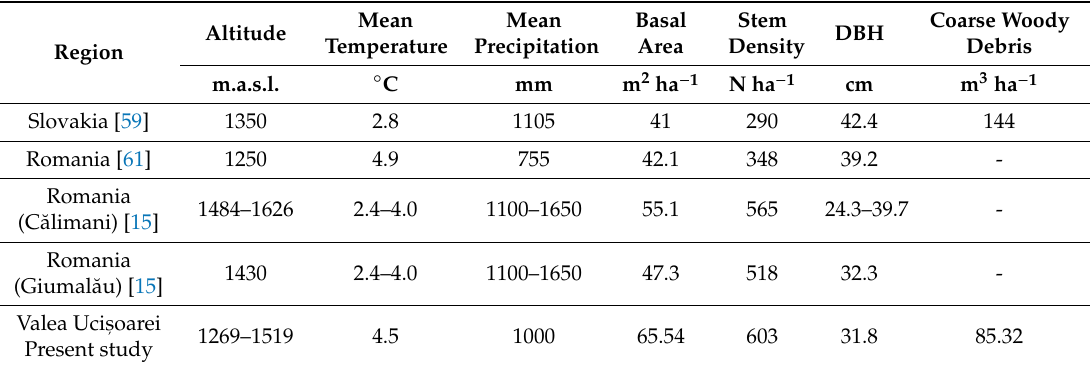
Table 3. Comparison of structural characteristics with results from other studies of primary forests.